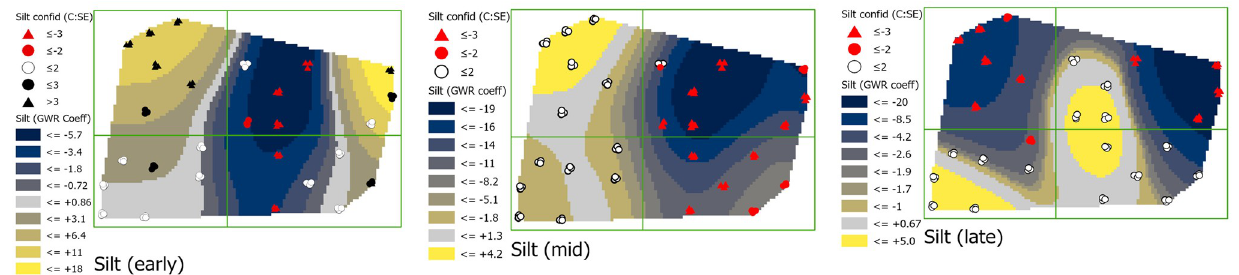
Fig 8. Maps showing early, mid-, and late season percent of silt without rock content (SILTNR) coefficients with estimations of credence in coefficient values. Coefficient surface values were symbolized using a geometric interval classification scheme from blue to gold, with grey indicating the interval including zero (if present).